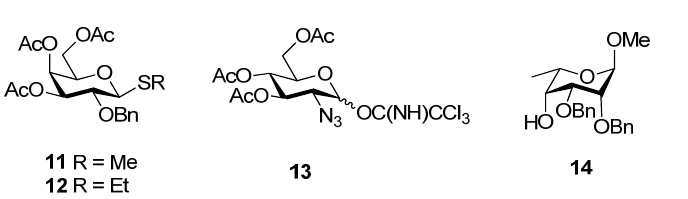
Figure 2. Glycosyl donors ( 11 – 13 ) and 6-deoxy- L -taloside acceptor ( 14